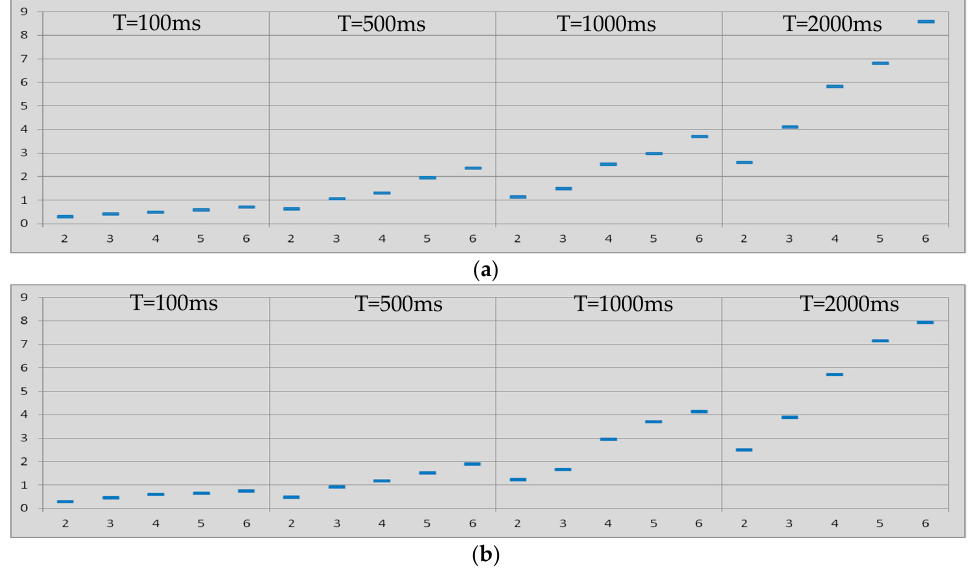
Figure 6. Latency (vertical, seconds) vs. amount of hops (horizontal). Links always in sniff mode. Inactivity intervals: 100, 500, 1000 and 2000 ms. ( a ) master-to-slave communication; ( b ) slave-to-master communication.